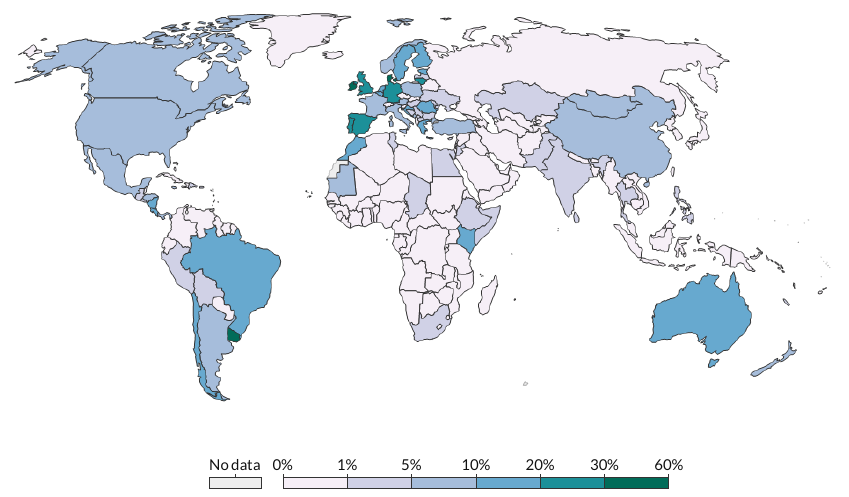
Figure 1. Electricity generated by wind energy in